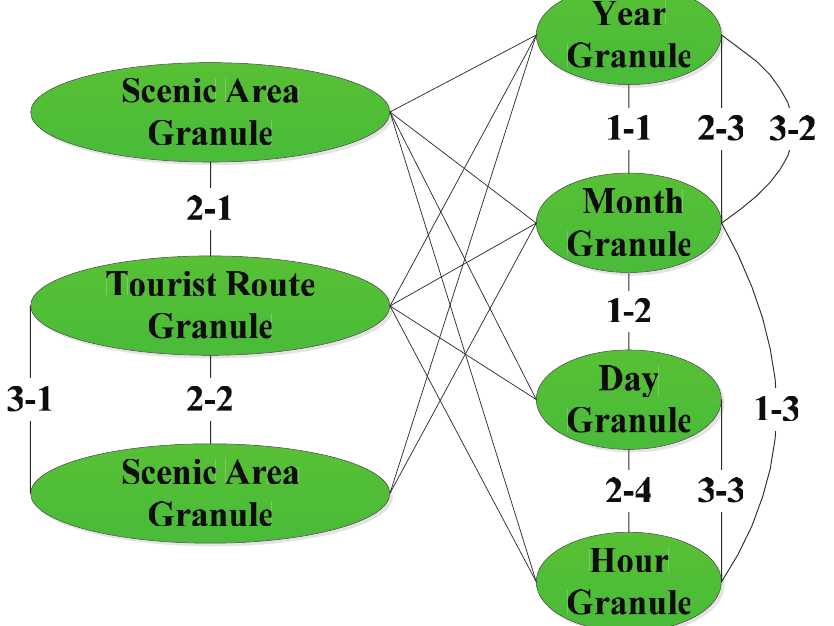
Fig 3. Correlation diagram of multi-spatiotemporal scale data in Jiuzhaigou .